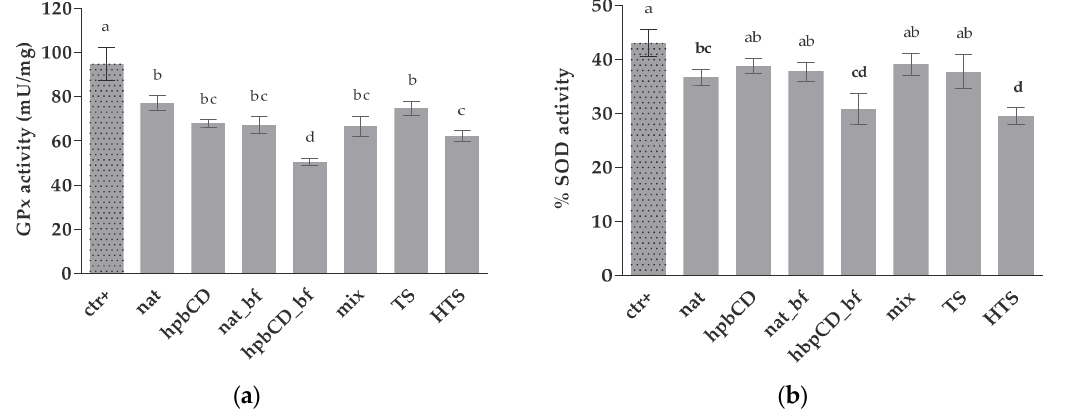
Figure 4. Effect of OPEs and pure polyphenols on enzyme activity. Data are presented as mean ± standard deviation ( n = 3) of the ( a ) GPx activity calculated according to Equation (3) and ( b ) SOD activity calculated according to Equation (4); Positive control cells (ctr+) were treated with PBS. The final concentrations of the samples in wells are noted in Table 1. Different letters (a, b, c, d) indicate statistically significant differences compared to ctr+ ( p < 0.05). Native olive pomace extract (nat), olive pomace extract with hydroxypropyl β -cyclodextrin (hpbCD); bioaccessible fraction (bf), tyrosol (TS), hydroxytyrosol (HTS), TS and HTS in the same concentration as in native sample (mix).